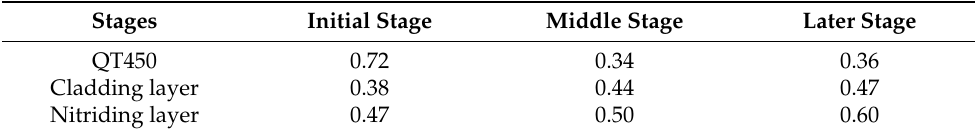
Table 4. Mechanical parameters of the materials.